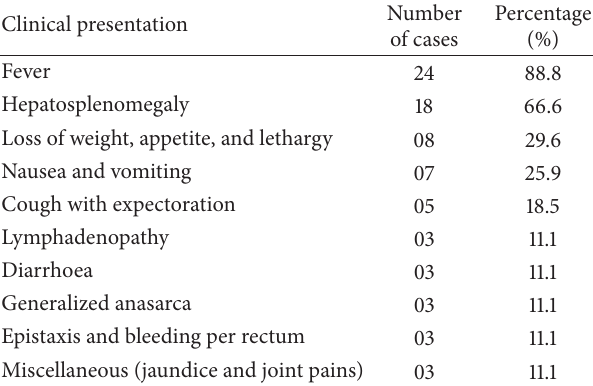
Table 1: Clinical presentation in cases showing Leishmania dono- vani amastigotes in bone marrow.